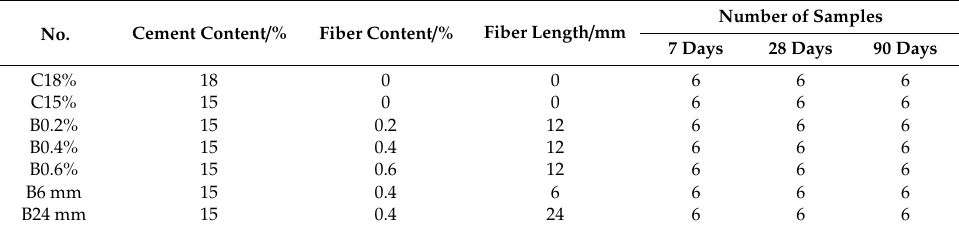
Table 3. Mixture design of test materials.